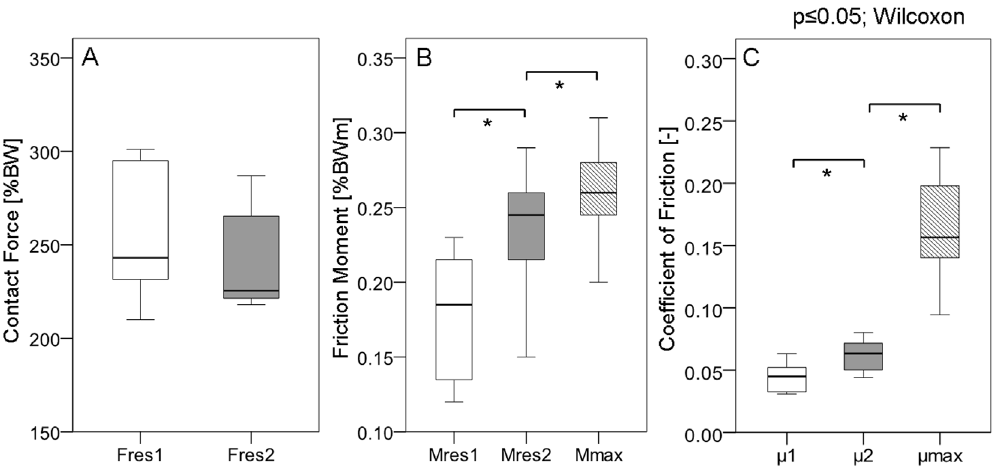
Figure 3. Peak values of contact force, friction moment and coefficient of friction. A: contact force F res , B: friction moment M res , C: coefficient of friction m . Individual numerical mean values and ranges from 8 subjects. M res1 |M res2 , m 1 | m 2 = values at the instant of the force maxima F res1 |F res2 (see Figure 2). M max , m max = absolute maxima during a whole walking cycle.